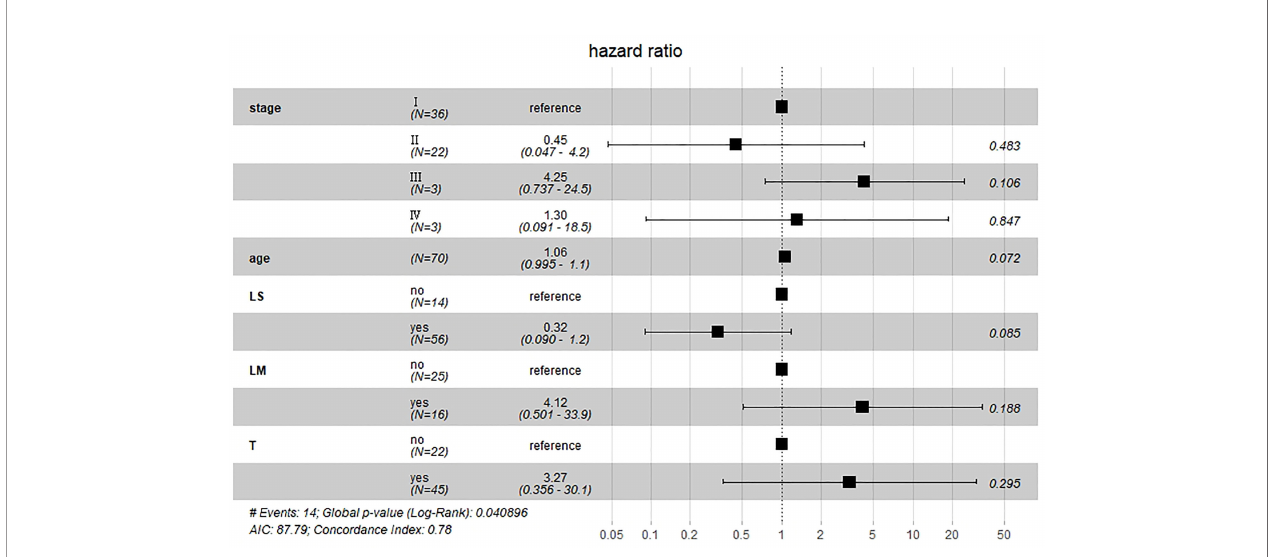
FIGURE 14 | Multivariate Cox hazard model analysis for RH-based patients. Lymphadenectomy reduces the risk of death, while lymphatic metastases and complementary other treatments increase the risk of